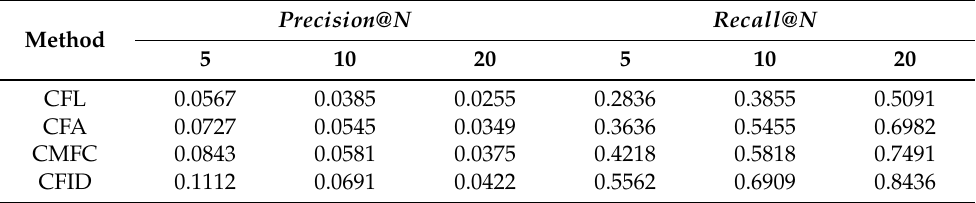
Table 5. Comparative results for multi-person group on New York City